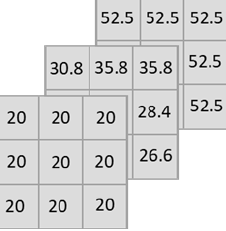
Figure 4. Scheme of method